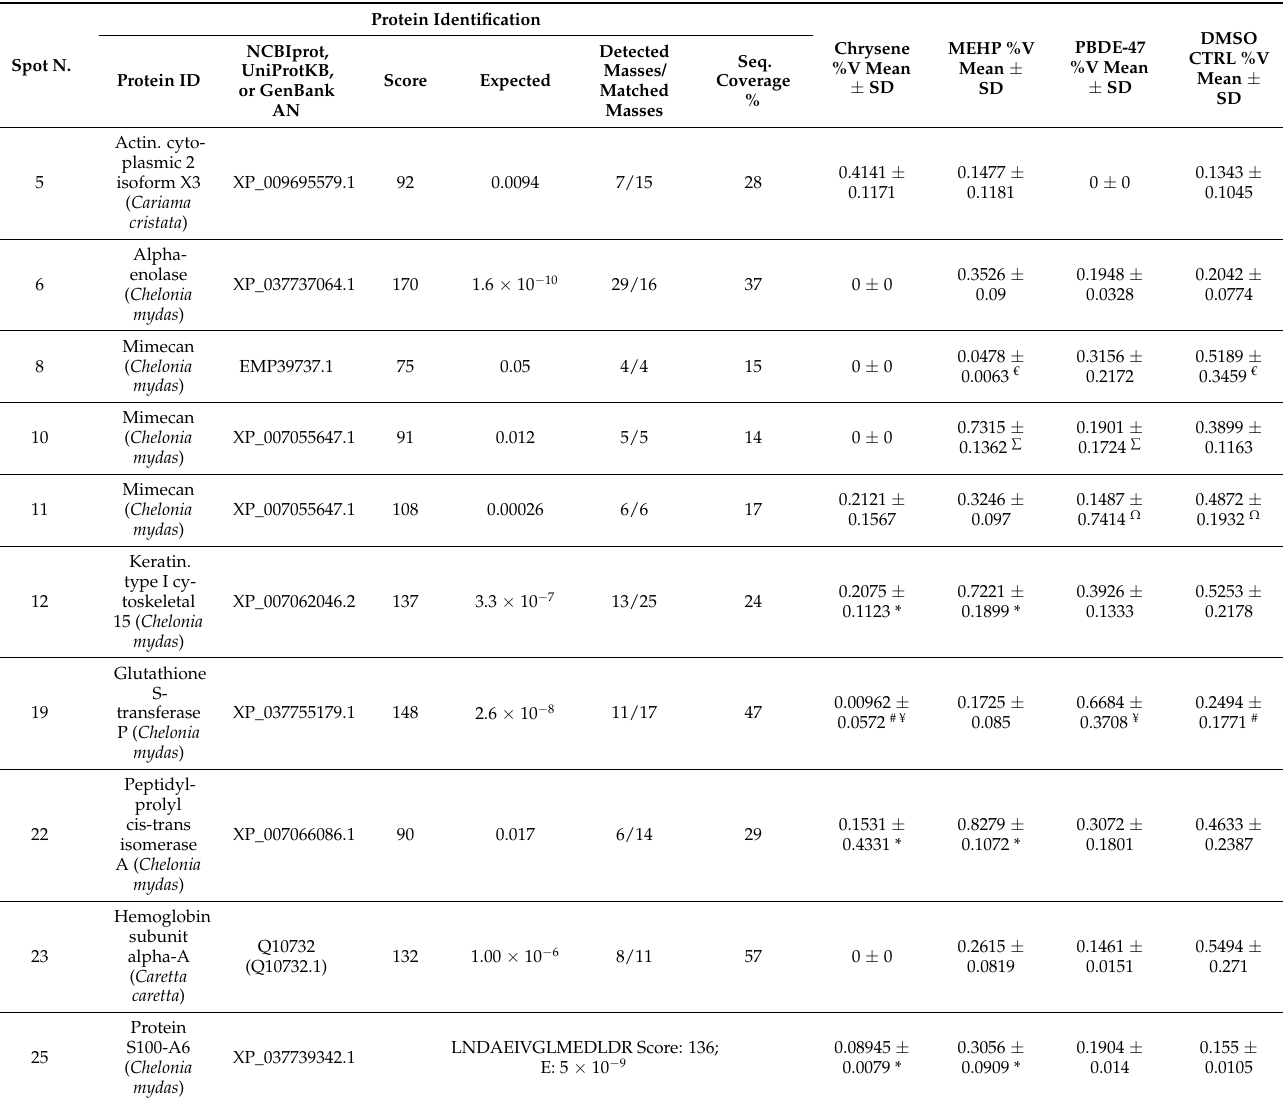
* # ¥ € ∑ Ω Symbols indicate significant quantitative differences occurring between the four tested conditions: *, chrysene vs. MEPH; ¥, chrysene vs. PBDE-47; #, chrysene vs. DMSO; ∑ , MEPH vs. PBDE-47; € , MEHP vs. DMSO; Ω , PBDE-47 vs.